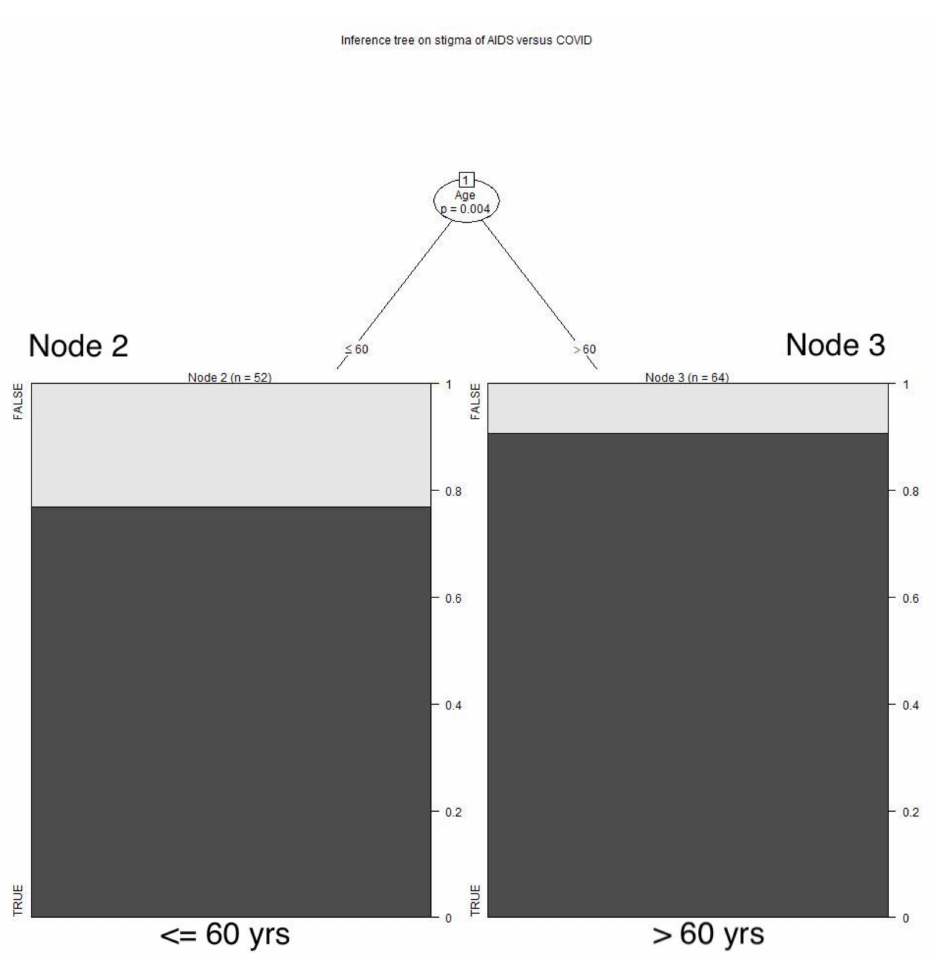
Figure 1. Stigma of AIDS versus COVID . Respondents who were more than 60 years of age more often rated the AIDS pandemic as involving significantly more stigma than the COVID pandemic, as compared with younger